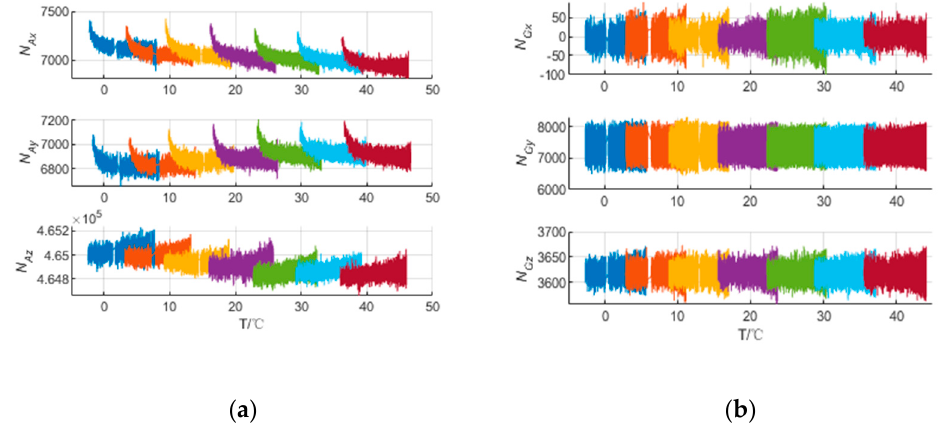
Figure 3. The IMU output at different temperature points. ( a ) The accelerometers outputs. ( b ) The gyroscopes